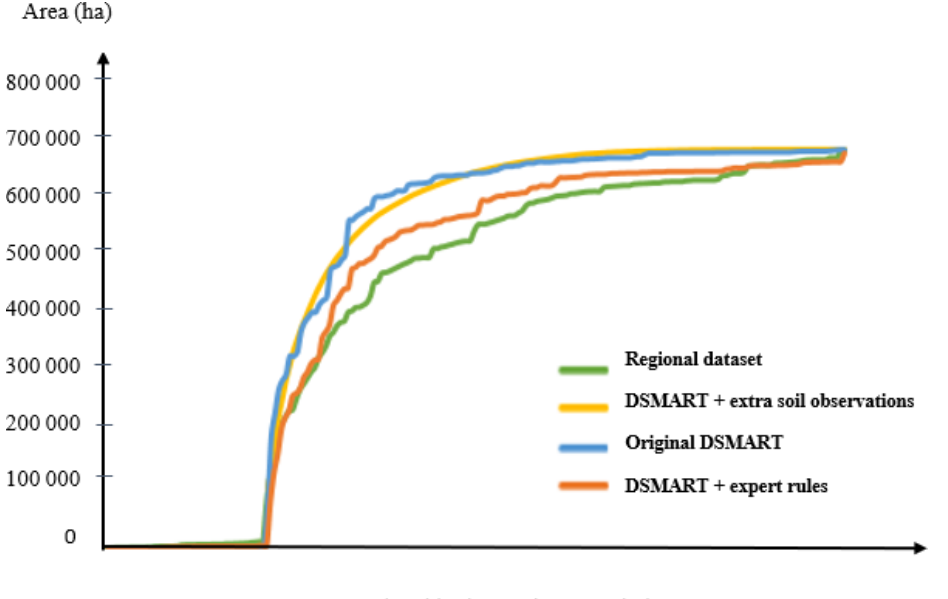
Figure 6. Cumulative area of the 171 STUs estimated from the regional soil database and predicted by different DSMART-based approaches.